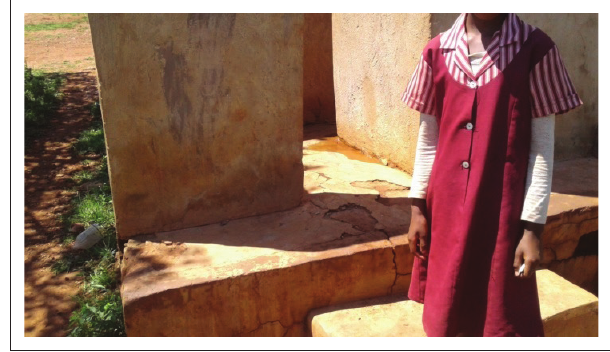
Source : Photograph taken by, Participant 8 FIGURE 4: Learner near school toilet with cracked walls and